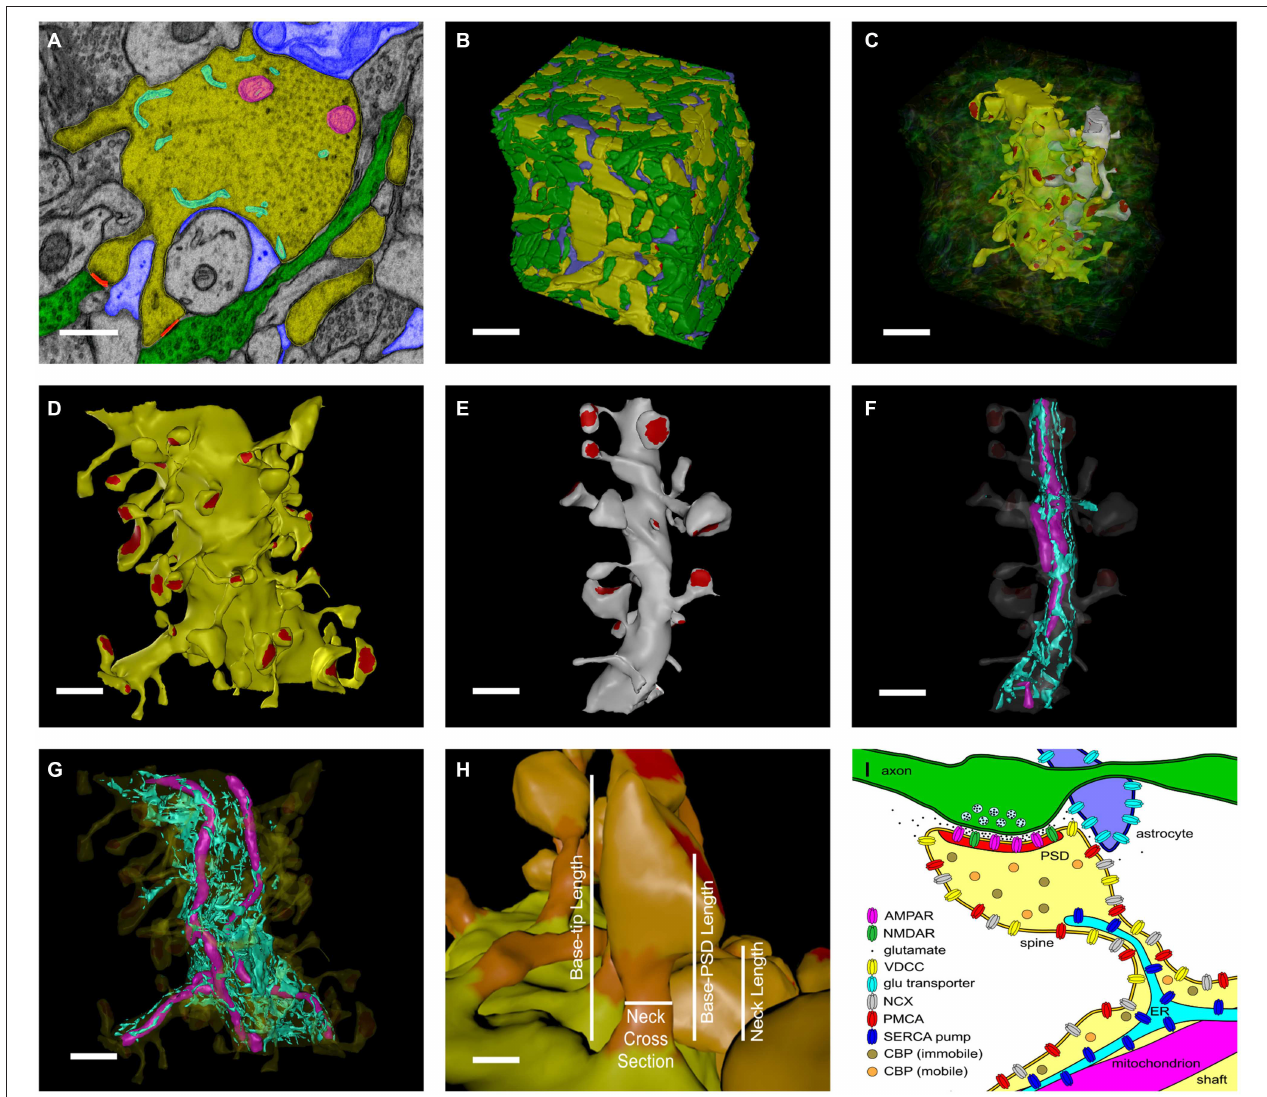
FIGURE 1 | Reconstruction of hippocampal neuropil. (A) Hand segmentation of 2D-objects within a single EM thin section. The entire reconstruction consisted of 100 serial EM thin sections 50nm thick. Each plasma membrane bound structure was traced in each thin section but only a few structures are highlighted here for illustrative purposes. A large apical dendrite is highlighted in yellow along with its enclosed endoplasmic reticulum (cyan) and mitochondria (magenta). Spines that are part of the principal dendrite, also shown in yellow, sometimes appear disjoint from the dendrite in a given thin section. Two axons that make synaptic contacts with two spines of the large apical dendrite in this plane of section are shown in green. PSDs and presynaptic active zones were annotated by enclosing them in a separate close-fitting contour (red). Processes of an astrocytic glial cell are shown in blue. Scale bar is 0.5 µ m. (B) Reconstructed volume of neuropil. Dendrites are yellow. Axons are green. Astrocyte is blue. The extracellular space was adjusted so that the distance between components was 20nm using an algorithm described in Kinney et al. (2013). Scale bar is 1 µ m. (C ) Two dendrites in the reconstructed volume were selected for simulations of glutamatergic synaptic transmission and postsynaptic calcium dynamics. A large apical dendrite is shown in yellow and a smaller branch dendrite is shown in light gray. The selected dendrites are shown in relation to one another embedded in the semitransparent neuropil. The synaptic contact areas (red) on the two selected dendrites were identified and labeled as shown in (D,E ). Scale bar is 1 µ m. (D,E) The PSD regions (red) of the large apical dendrite (D) and the smaller branch dendrite (E) were annotated. Scale bar is 1 µ m. (F,G) Intracellular organelles of the small branch dendrite (F) and large apical dendrite (G) , including the reconstructed endoplasmic reticulum (cyan) and mitochondria (magenta). Scale bar is 1 µ m. (H) The spine head (light-orange), neck (dark-orange), and dendritic shaft (yellow) were also annotated. Geometric measurements used in the analysis are shown as annotations. The neck cross section area was measured at a point halfway along the length of the neck. Scale bar is 0.25 µ m. (I) Summary of all neuropil elements included in the model. The PSD was used to lasso a region of the spine surface for NMDAR and AMPAR placement. Presynaptic vesicles are shown for illustration only and were not included in simulations; instead glutamate was released directly into the synaptic cleft (see Methods Section). Note that about 19% of spines in the reconstruction contained ER protruding from the dendritic shaft into the spine neck and head.